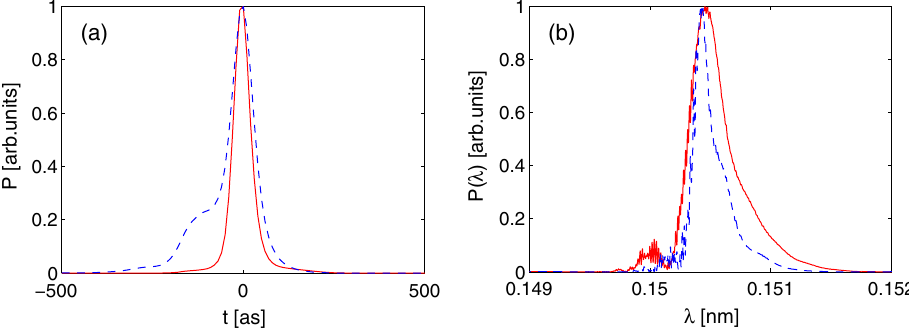
FIG. 5. Comparisons of the single shot radiation pulse (a) and corresponding spectra (b) from the proposed scheme with an initial electron beam peak current of 3 (blue dashed line) and 1 kA (red solid